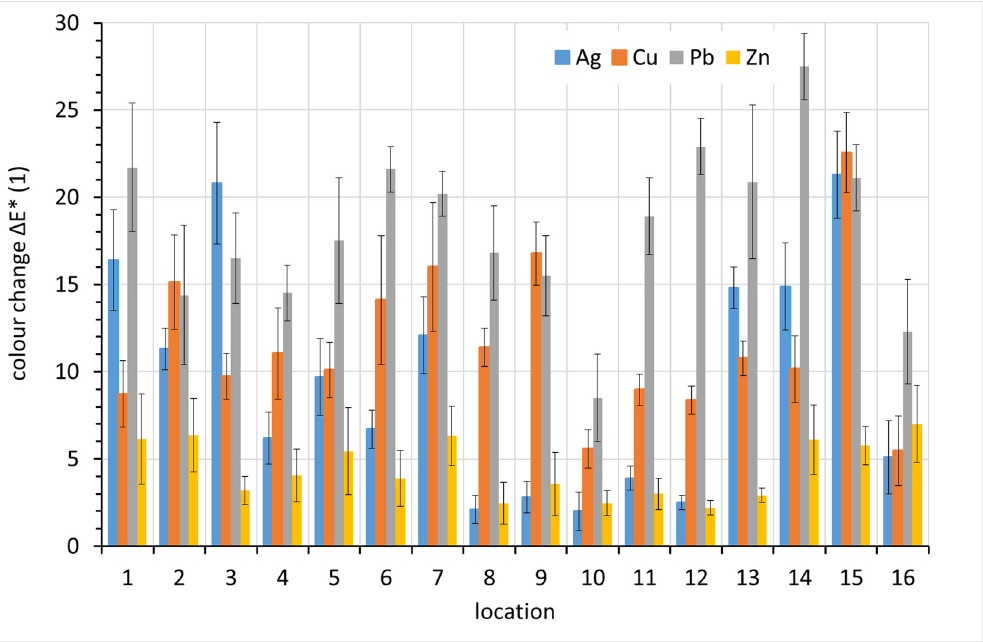
Figure 10. Color change of coupons after a year of exposure (average values from 10 recordings supplemented with standard deviation error bars).